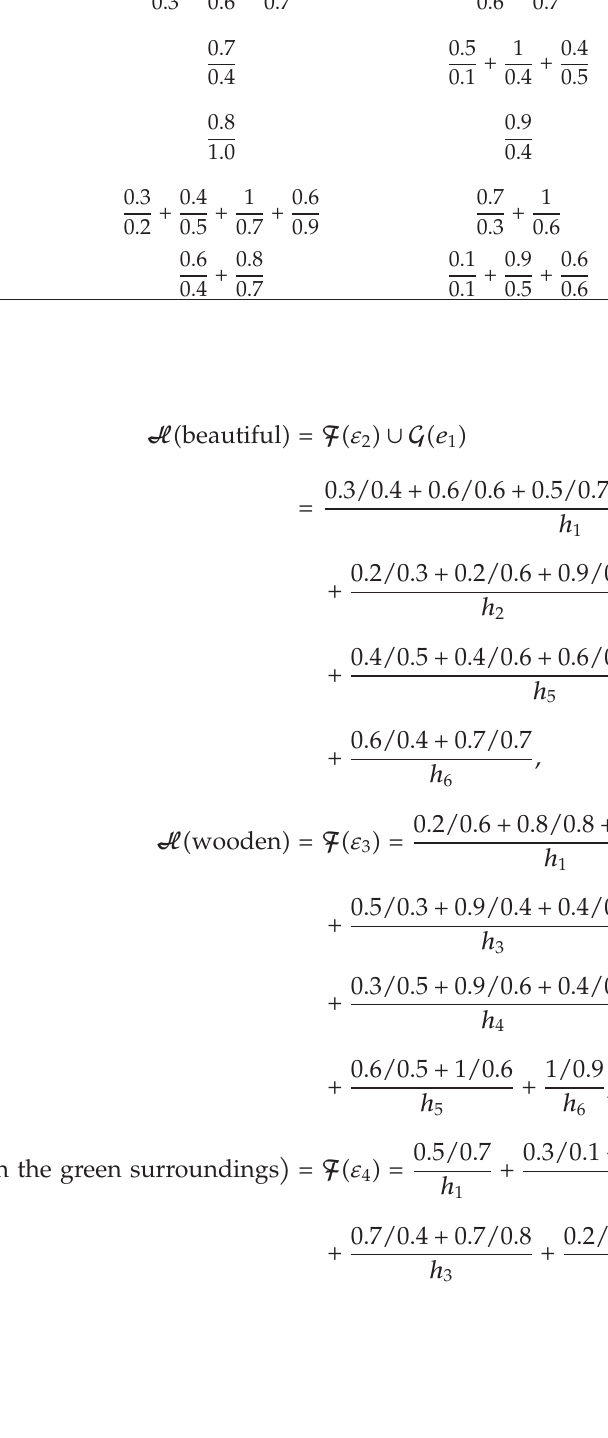
Table 3: A type-2 fuzzy soft set (cid:5) G , B (cid:6) . U e 1 e 2 e 3 h